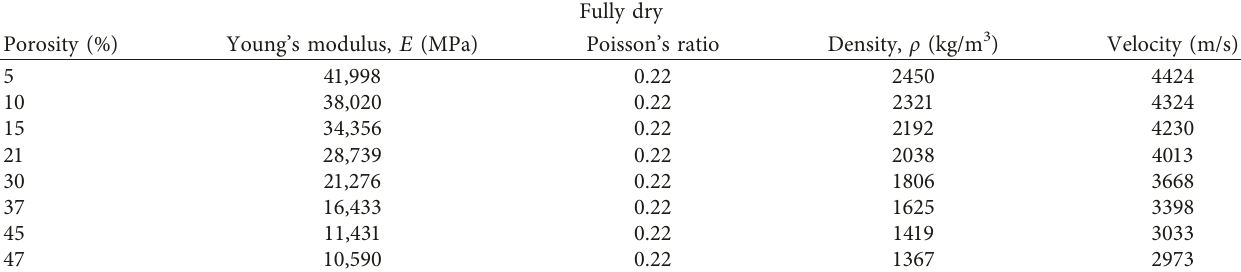
Table 5: Results for simulating different porosities under fully dry situation.